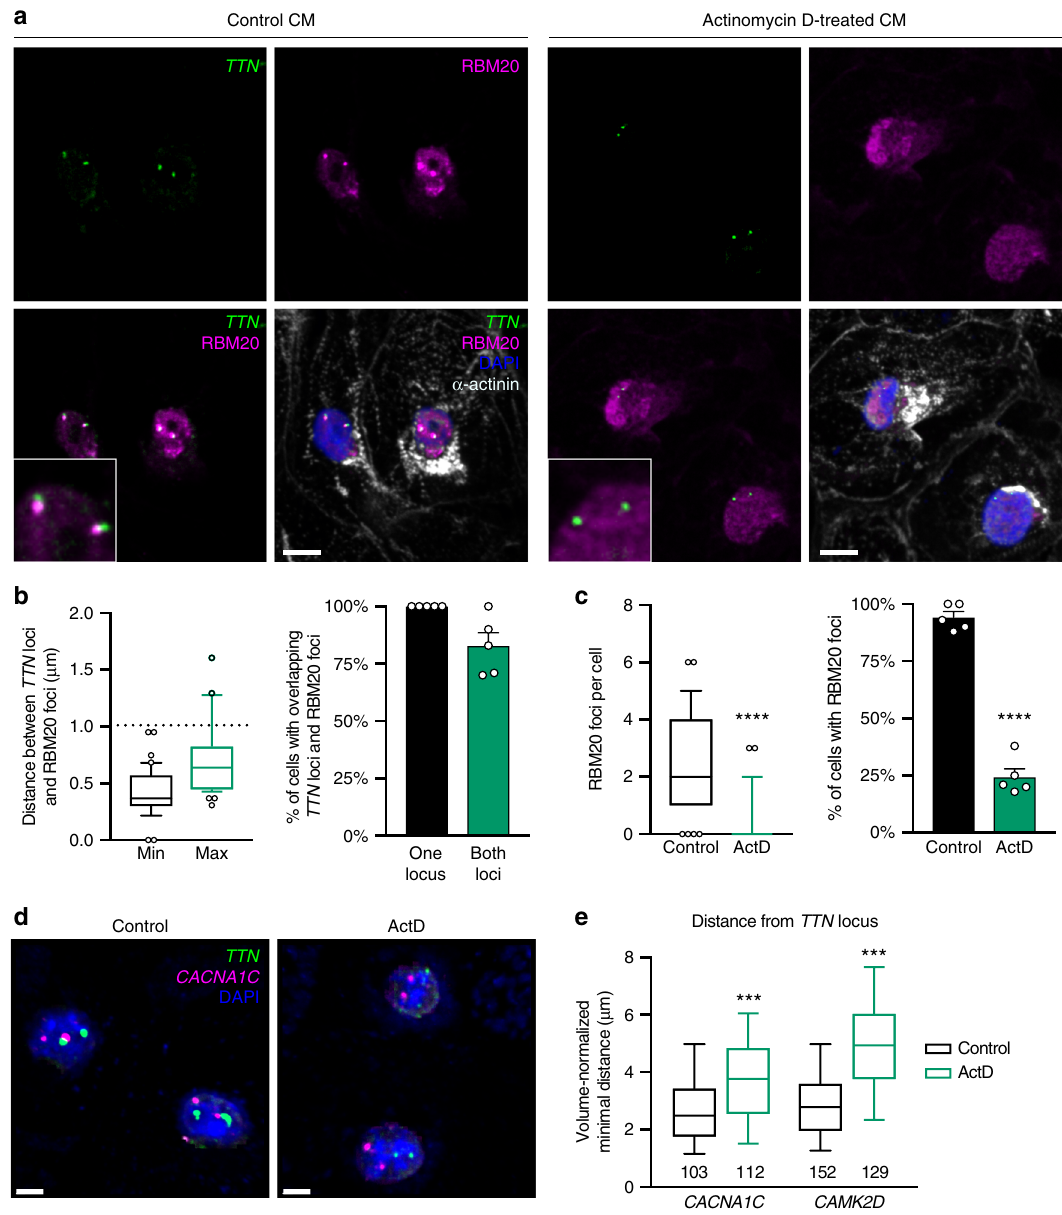
Fig. 7 TTN trans interactions are transcription-dependent. a Representative results of immuno fl uorescence for RBM20 and α -actinin combined with DNA FISH for the TTN locus in CM (immunoFISH; nuclei counterstained with DAPI); scale bars: 10 µ m. Insets show magni fi ed views. Cells were maintained in standard culture conditions or treated with 5 µ M Actinomycin D. b Quanti fi cation of distance relationships between RBM20 foci and TTN loci in control conditions. Center-to-center distance below 1 µ M (twice the radius of 3D-resconstructed spots) was used to determine overlap (see Methods). On the left, box and whiskers plots showing median, 25th and 75th percentile, and the 10 – 90 percentile range plus outliers; n = 40 diploid cells. On the right mean ± s.e.m.; n = 5 fi eld of views. c Quanti fi cation of RBM20 foci in control and Actinomycin D-treated CM. Graphs are as described for panel ( b ) except that on the left n = 64 and 55 cells for CTR and ActD, respectively. Note that all CM were considered, including polyploid cells with more than two RBM20 foci. p values by Mann – Whitney test (left) or Welch ’ s t -test (right); **** < 0.0001. d Representative 3D FISH images of control and Actinomycin D-treated CM; scale bars: 5 µ m. e Normalized minimum distance per diploid CM between TTN and the indicated loci (the number of cells is reported). Box and whiskers plots show median, 25th and 75th percentile, and the 10 – 90 percentile range. p -values by Kruskal – Wallis test followed by Dunn ’ s multiple comparisons vs Control; *** < 0.001. Source data are provided as a Source Data fi